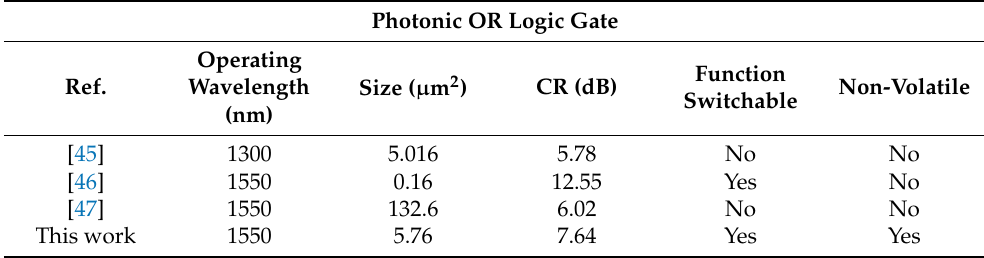
Table 2. Performance comparison between the proposed photonic OR logic gate and several refer- ence structures reported in other papers.